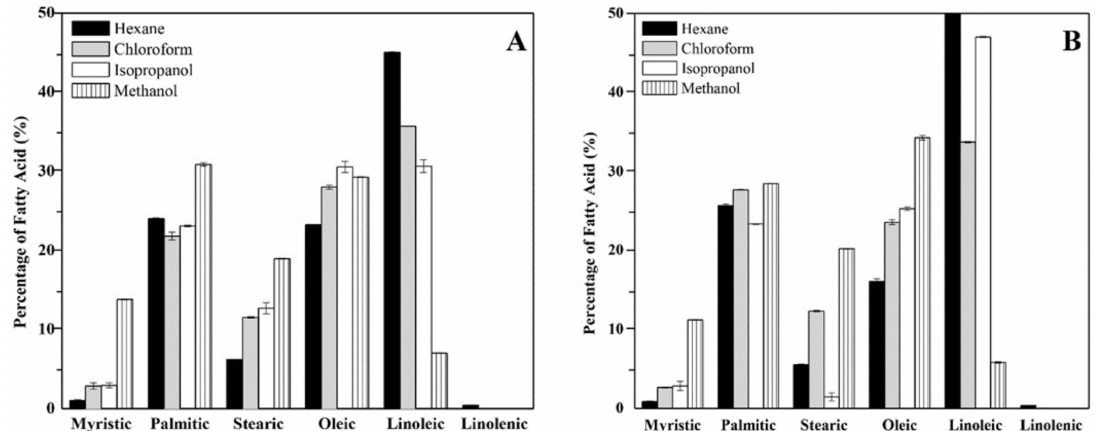
Figure 1. Fatty acid profile of the lipid extracts associated to the external surface of the cell wall in the mycelial phase of the environmental ( A ) and clinical ( B ) isolate of H. capsulatum